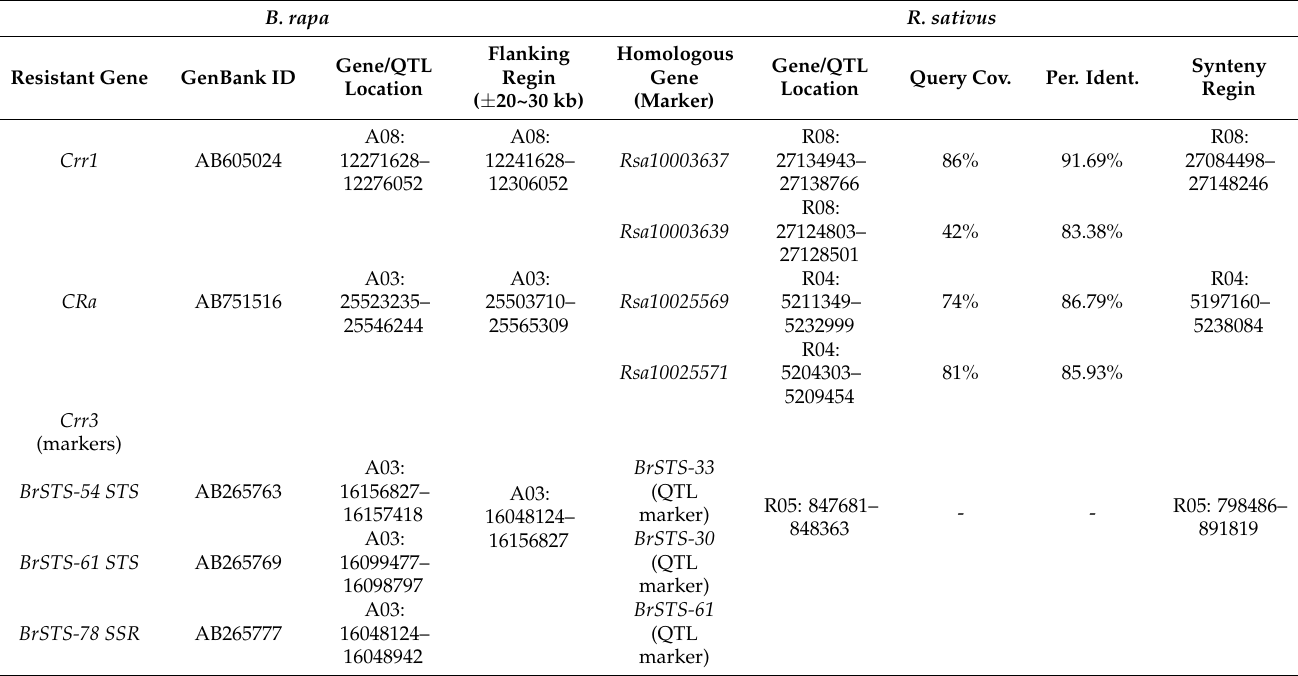
Table 2. Homology and synteny analysis of the clubroot resistance genes Crr1 , CRa , and Crr3 QTL